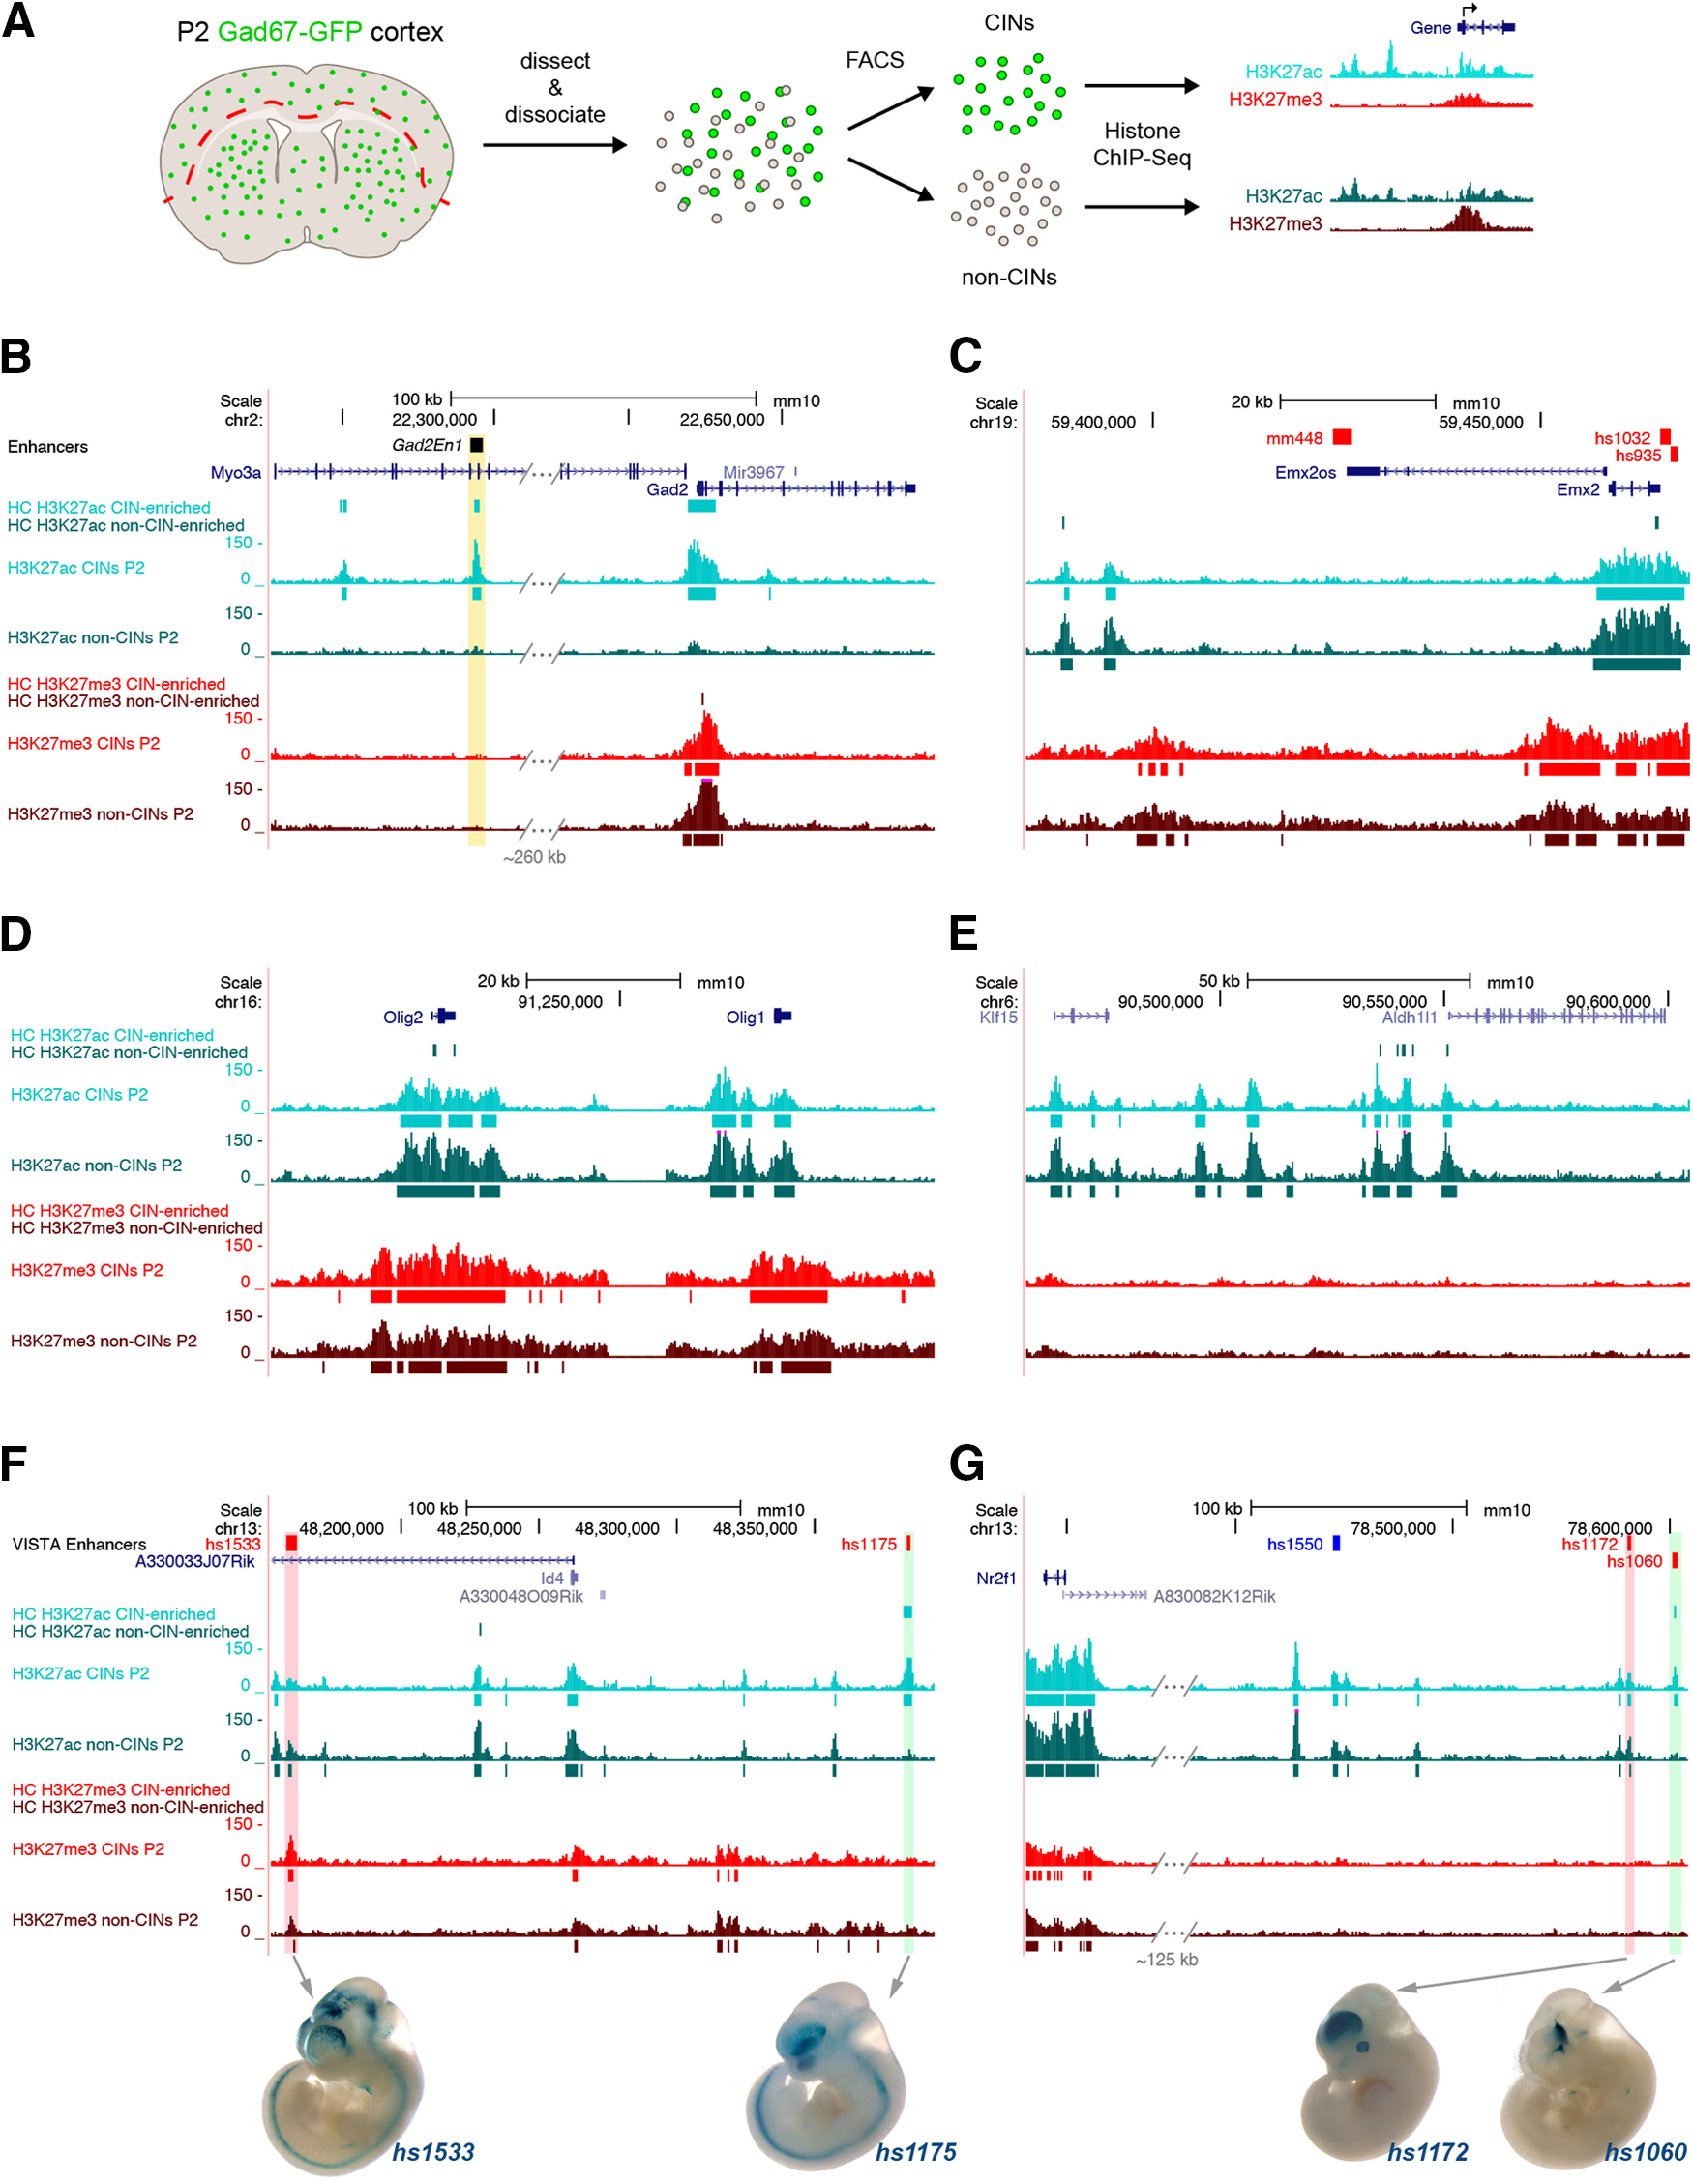
 ChIP-seq reveals differential enrichment of histone modifications in P2 CINs and non-CINs. A, Schematic showing the histone modification ChIP-seq workflow using CINs and non-CINs dissected and FACS-purified from P2 Gad67-GFP neocortex. B–E, Enrichment of H3K27ac (active mark, cyan and teal) and H3K27me3 (repressive mark, red and dark red) around genes expressed in CINs (Gad2), PNs (Emx2) oligodendrocyte-lineage cells (Olig1, Olig2), and astrocytes (Aldh1l1). Gad2En1 is a validated enhancer with activity in adult CINs (yellow highlight; Pla et al., 2017). F, G, H3K27ac enrichment is similar in CINs and non-CINs across the gene body for Id4 and Nr2f1 but differentially enriched at enhancers with validated activity in the basal ganglia (green highlights) or cortex (red highlights). Whole-mount transient transgenics from the VISTA browser show the pattern of enhancer activity at E11.5 (https://enhancer.lbl.gov; Visel et al., 2013). ChIP-qPCR validation of H3K27ac enrichment at highlighted enhancers is shown in Extended Data Figure 1-1. HC called peaks are shown as solid bars under the corresponding bigwig tracks.